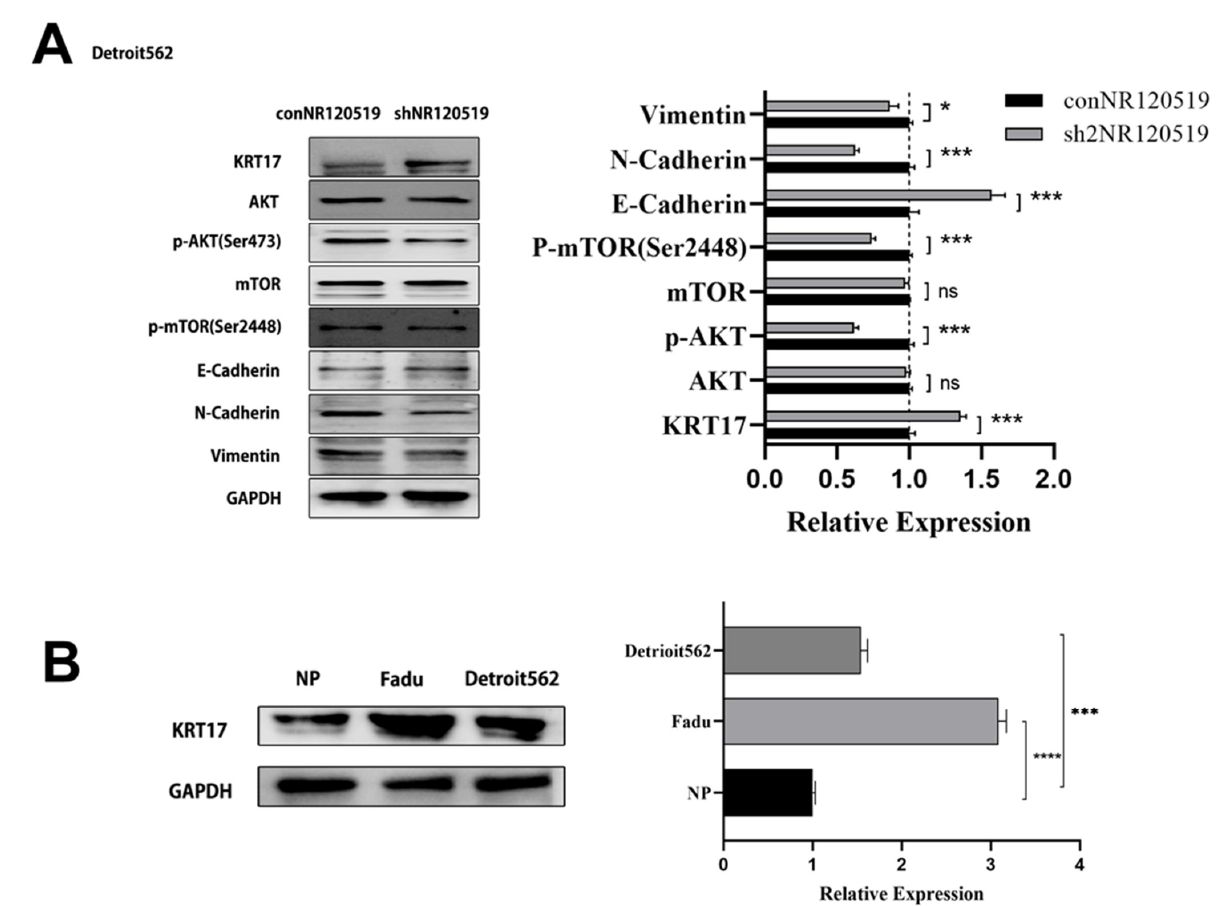
Figure 4. Knockdown of NR120519 in Detroit562 cell line inhibits AKT/mTOR pathway and in- creases KRT17 expression. ( A ) Western blotting experiments involving knockdown of NR120519 (sh2NR120519) and control (conNR120519 groups to detect the expression of KRT17, AKT/mTOR, and EMT pathway-related proteins. ( B ) Western blotting assay to detect KRT17 expression in NP, Fadu and Detroit562 cell lines. * p < 0.05; *** p < 0.001; **** p < 0.0001; ns no significance. The uncropped bolts are shown in Supplementary Materials File S1.